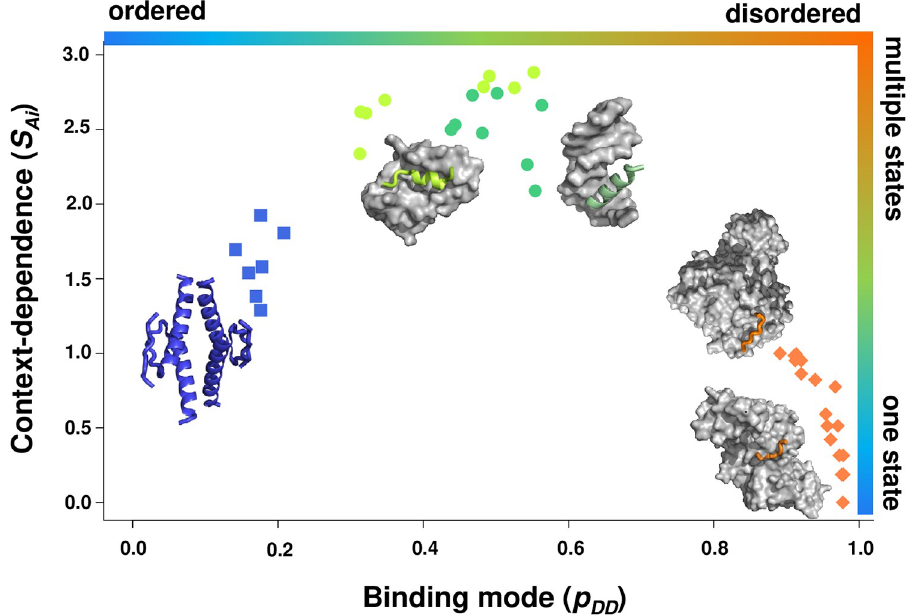
Fig 6. Binding mode landscape for p53 interactions. The oligomerisation domain (residues 325–356, blue squares) exhibits a strong preference for disorder-to-order transitions and forms stable tetramers (PDB:1c26) [36] and higher- order structures. Short linear peptides (residues 378–386, orange diamonds) at the disordered C-terminal regulatory region interact with sirtuin (PDB: 4zzj [37]) and the cyclin dependent kinase cyclin A (PDB:1h26 [38]) exhibit heterogeneous binding modes. On the top of the binding mode landscape two context-sensitive regions are shown. The disordered N-terminal transactivation region interacts with Mdm2 (PDB:1ycr [58]) via a short helical segment (19–25 aa, lime dots). The beginning of the disordered C-terminal region folds into an α -helical conformation (residues 278–285, green dots) to recognise DNA via a variety of dynamic binding modes (PDB: 2ady, [36]). The high values for both regions indicate fuzzy interactions, which are strongly influenced by the cellular context. The S A i interaction sites are shown by the same colours as interaction modes, and partner proteins are displayed by grey